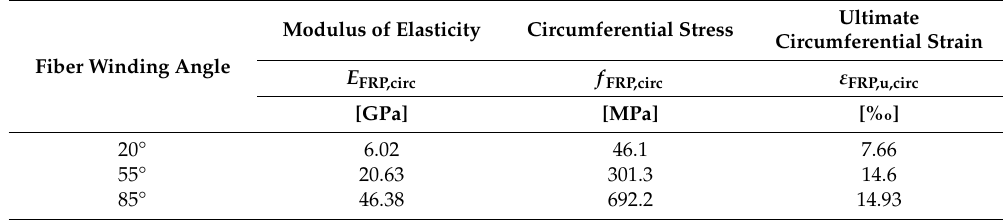
Table 4. Medium values of mechanical parameters of pipe composite at circumferential tension stress.